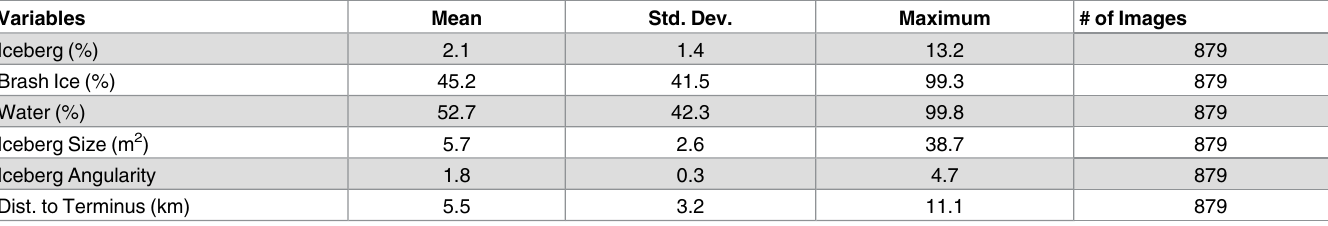
Table 2. Summary of results of object-based image analysis per